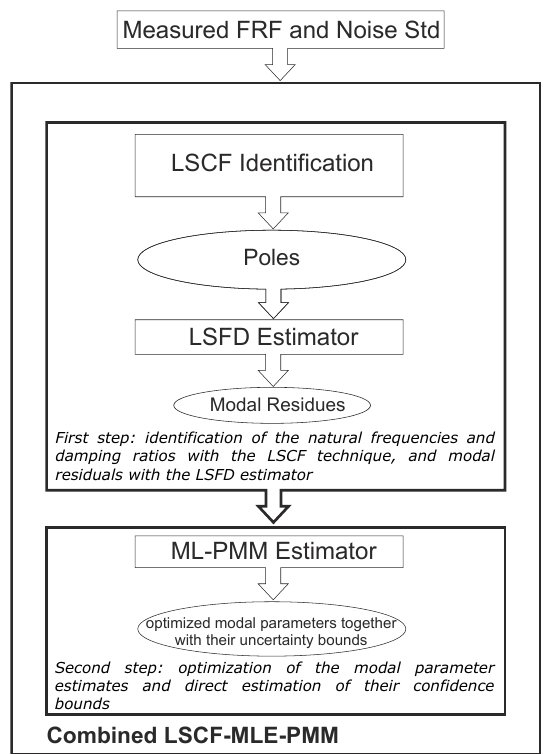
Figure 1. Chart flow of the identification with the combined LSCF-MLE-PMM